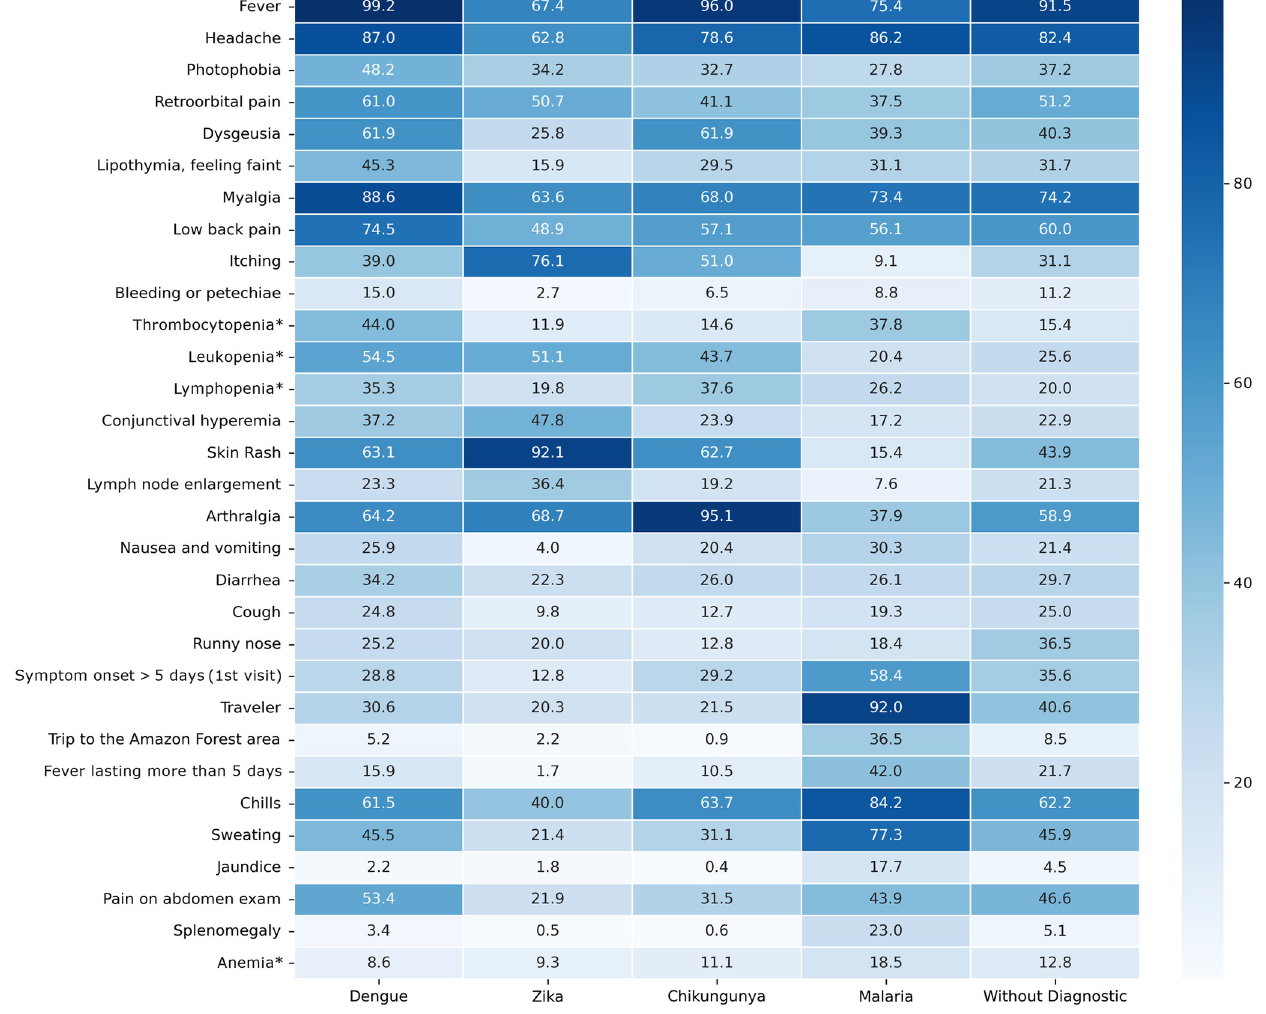
Fig 3. Comparison of the frequency (%) of clinical and laboratory findings reported at the first visit, according to the result of the etiological investigation (N = 3360). Co-infections and diagnosis with n � 200 not included in this clinical description. Chi-square test showed significant differences among study groups: p < 0.001 for all variables except for diarrhea (p = 0.003). * See S1 Table for the definition of anemia, leukopenia, lymphopenia and thrombocytopenia definitions